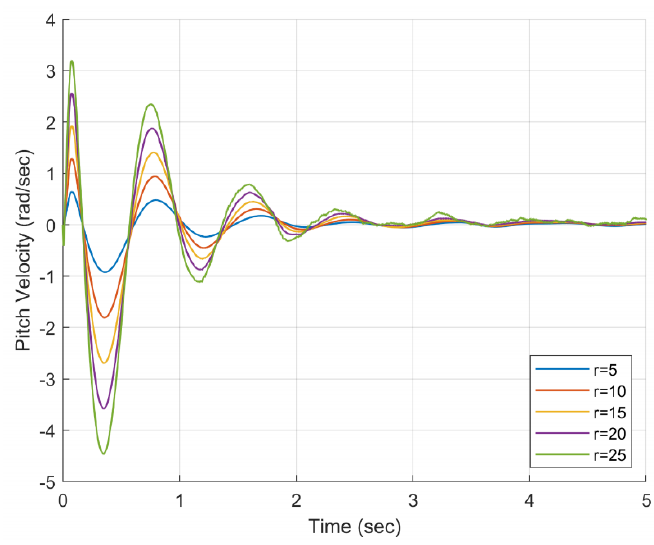
Figure 9. Variation of pitch velocity at different scale factors.